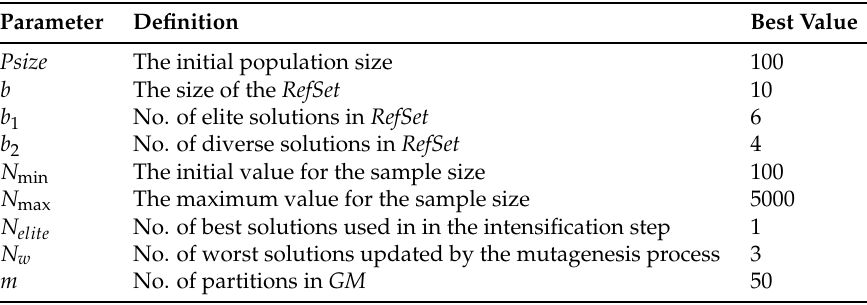
Table 5. DSS and DSSSP parameters.